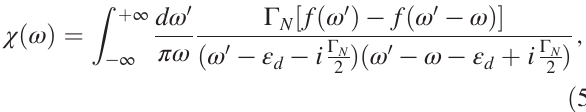
of the dot d and g N